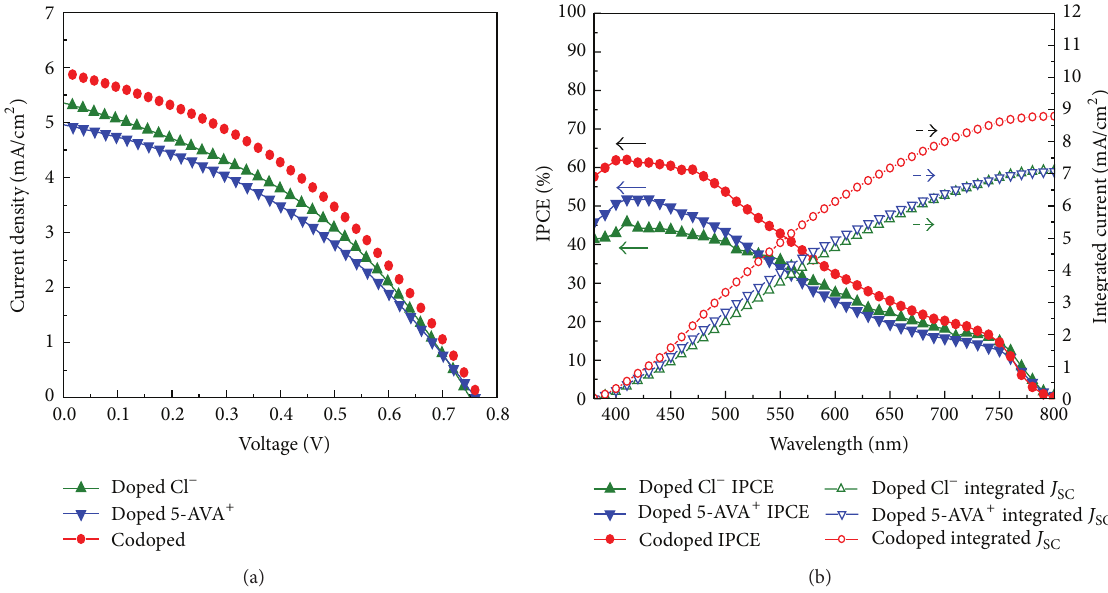
Figure 9: (a) J - V characterization of the optimal single-mesoporous-based PSCs with doping Cl − , 5-AVA + , and codoping (Cl − and 5-AVA + ). (b) The IPCE curves and integrated photocurrent curves of the best-performing single-mesoporous-based devices with doping Cl − , 5-AVA + , and